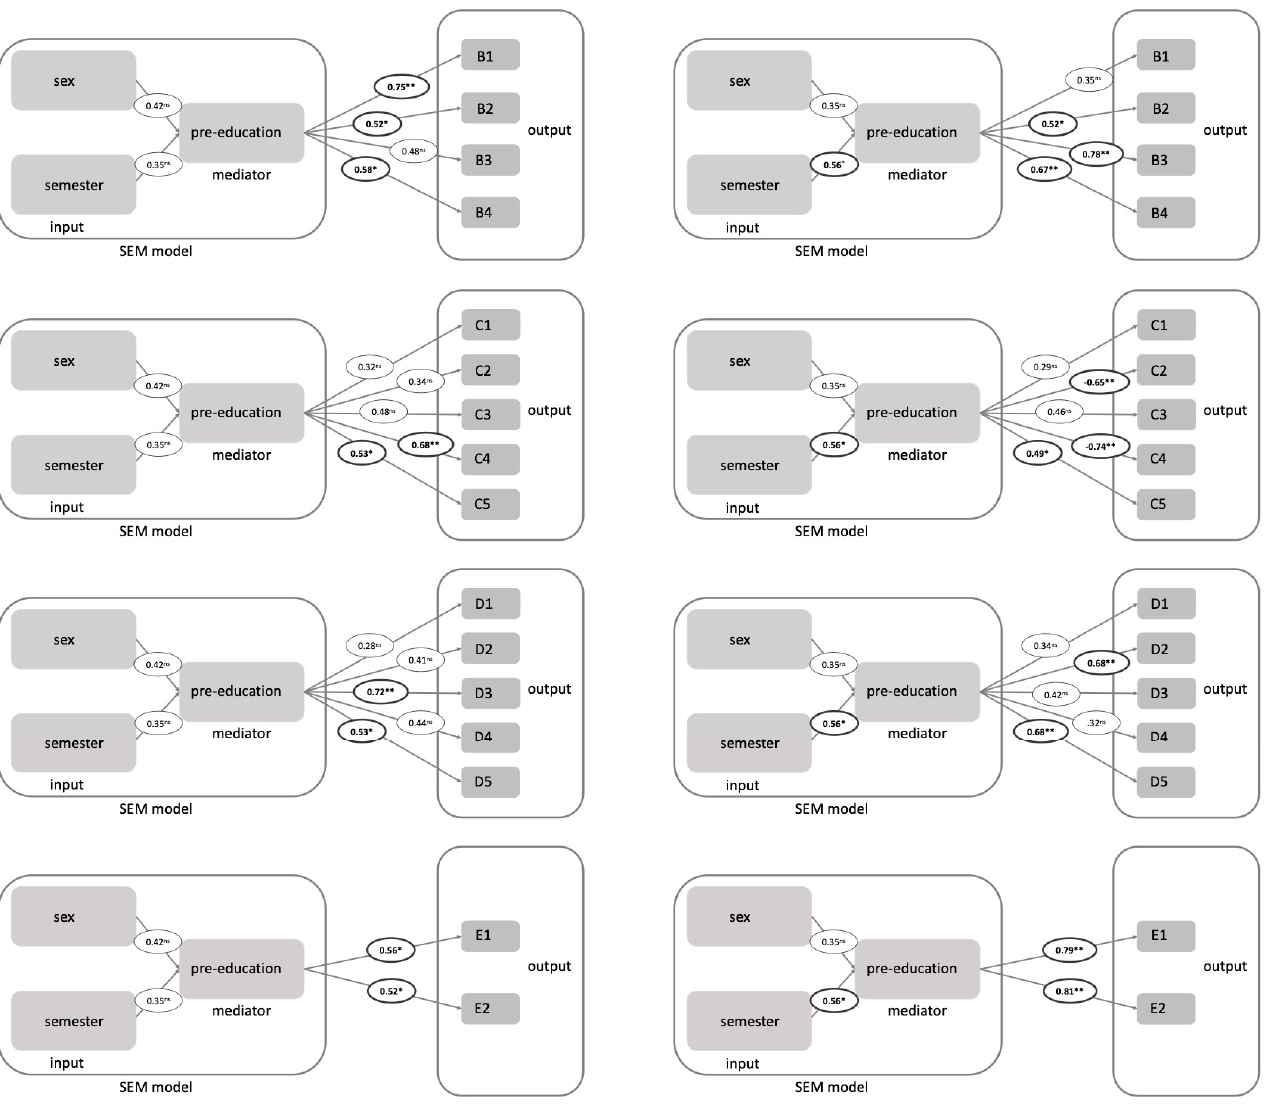
Figure 2. Structural equation modelling for sex, semester as input and pre-education as mediator and the corresponding prediction coefficients are written in circles for each question separately. The ** indicates significance p < 0.01 and * indicates significance of p < 0.05. ns indicates not significant.